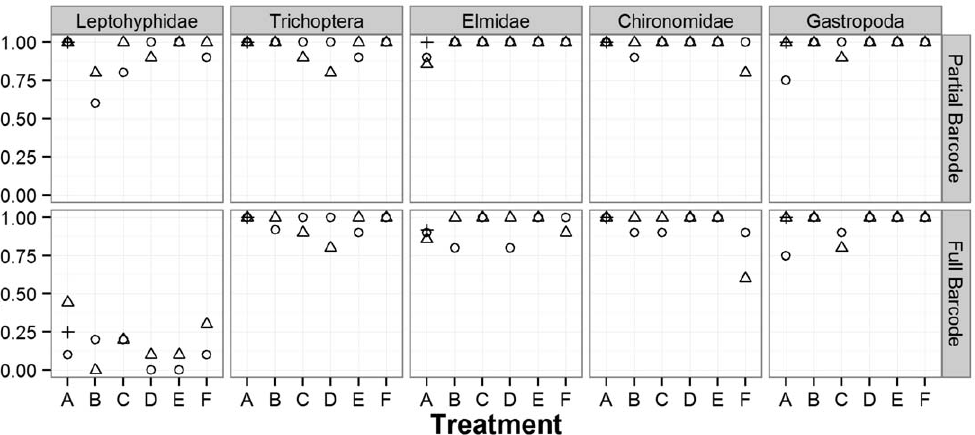
Figure 1. Proportion of specimens successfully amplified for two different sequence length criteria, Partial barcodes (top) and Full barcodes (bottom). Replicates are represented by different shapes (circles, pluses and triangles). Treatment designations (A–F) are as indicated in